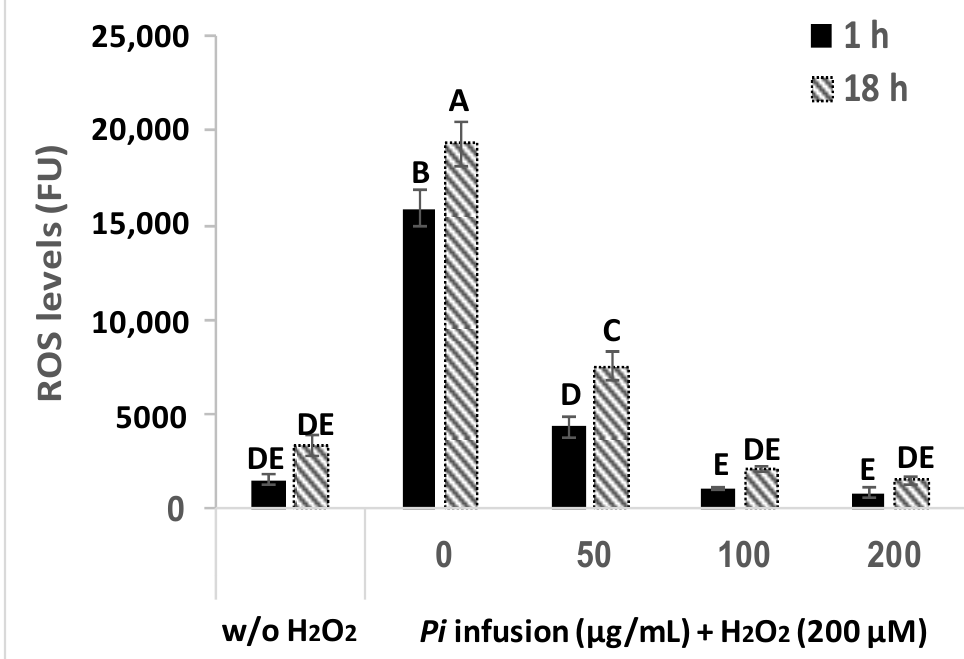
Figure 4. Pi infusion reduces H 2 O 2 -induced increases in intracellular reactive oxygen species (ROS) levels in neuronal cells. Cells were labeled with (2’7’-dichlorofluorescein diacetate) DCF-DA and washed, before being treated with increasing concentrations of Pi infusion for 2 h. Then, hydrogen peroxide (200 µM) was added to the medium and fluorescence levels were measured 1 h and 18 h thereafter. The results are presented as mean ± SEM and represent two independent experiments ( n = 12). The results were analyzed by one-way ANOVA followed by the Tukey – Kramer multiple comparison test. Columns marked with different letters (A, B, C, etc.) represent statistically significant differences ( p < 0.05).